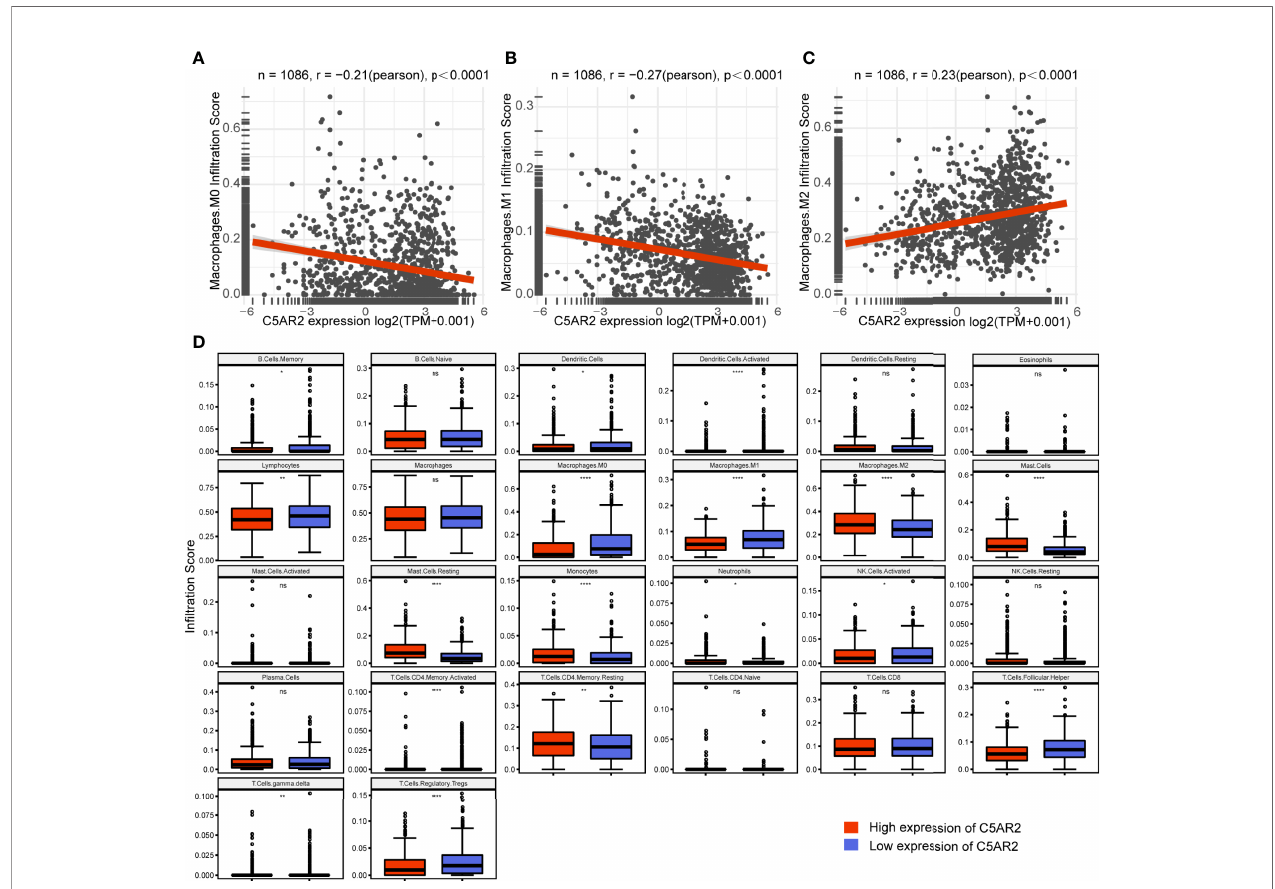
FIGURE 3 | Relationships of C5AR2 expression to immune in fi ltration in breast cancer. (A – C) Relationships of C5AR2 expression to the in fi ltration scores of macrophages. (D) The in fi ltration levels of 26 tumor-in fi ltrating immune cells compared in the high and low C5AR2 expression groups in breast cancer. NS, not signi fi cant, *P < 0.05, **P < 0.01, and ****P <